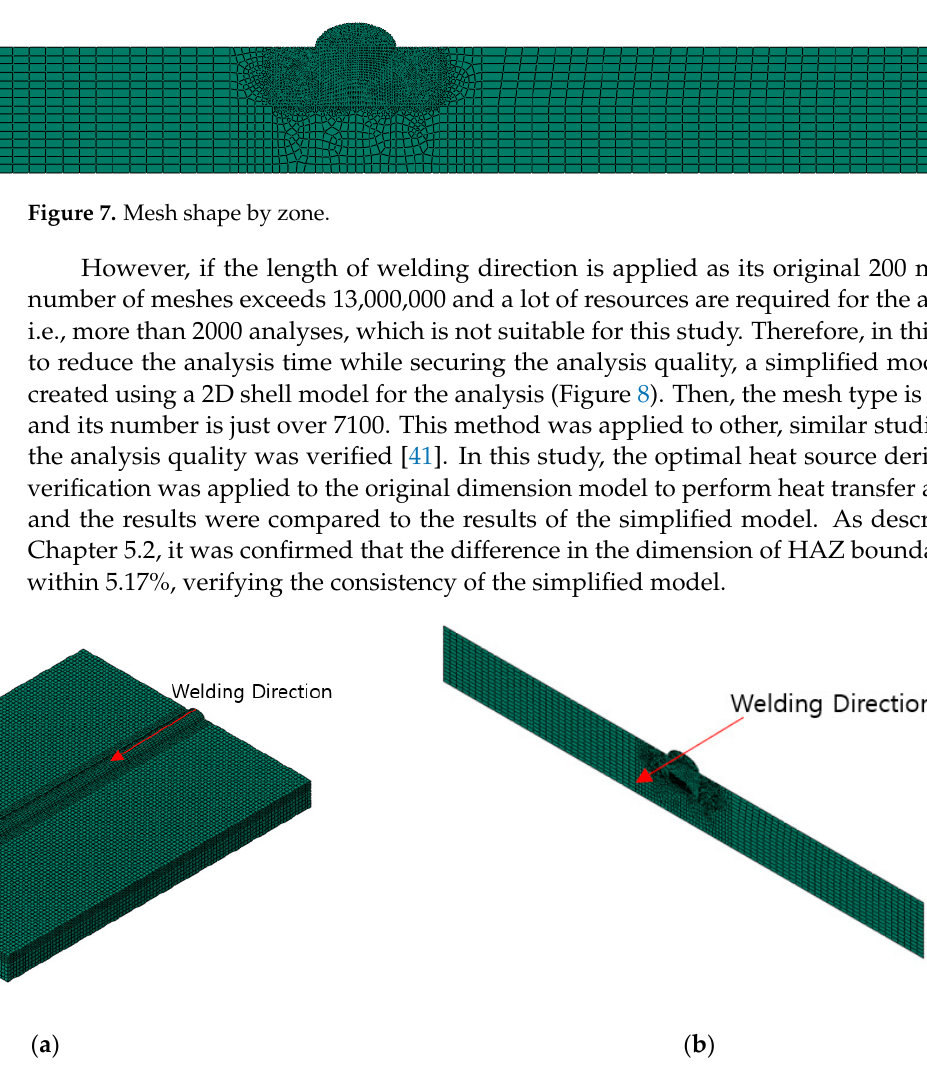
Figure 8. Original dimension model and simplified model. ( a ) Original dimension model (with coarse meshes). ( b ) Simplified model (with fine meshes).